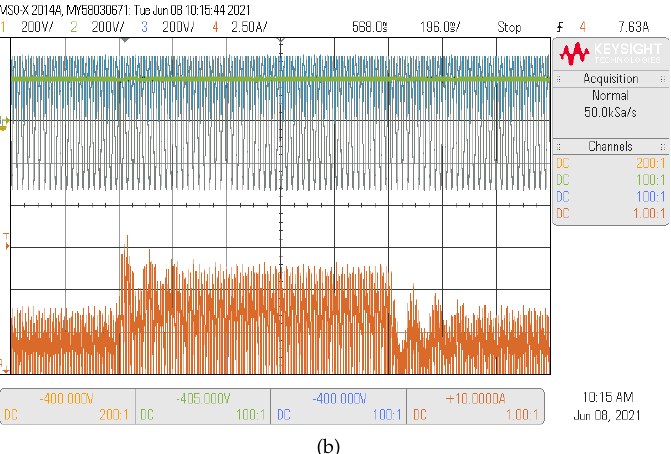
Figure 13. Simulated ( a ) and experimental ( b ) dynamic behavior of the double loop for a 50% step change in the load. CH1: v ac (200 V/div), CH2: v o (200 V/div), CH3: v g (200 V/div), CH4: i g (2.5 A/div) and a time base of 196